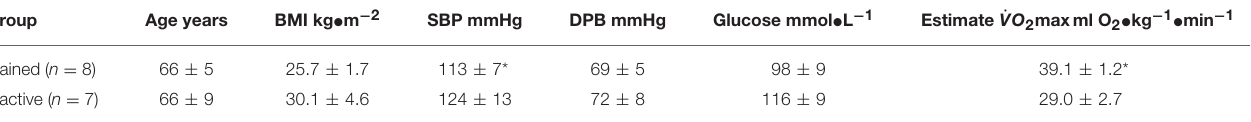
Values represent mean ± 1 SD for each group. BMI, body mass index; SBP, systolic blood pressure; DBP, Diastolic blood pressure; ˙ VO 2 max, maximal oxygen consumption. * p < 0.05 different from untrained.